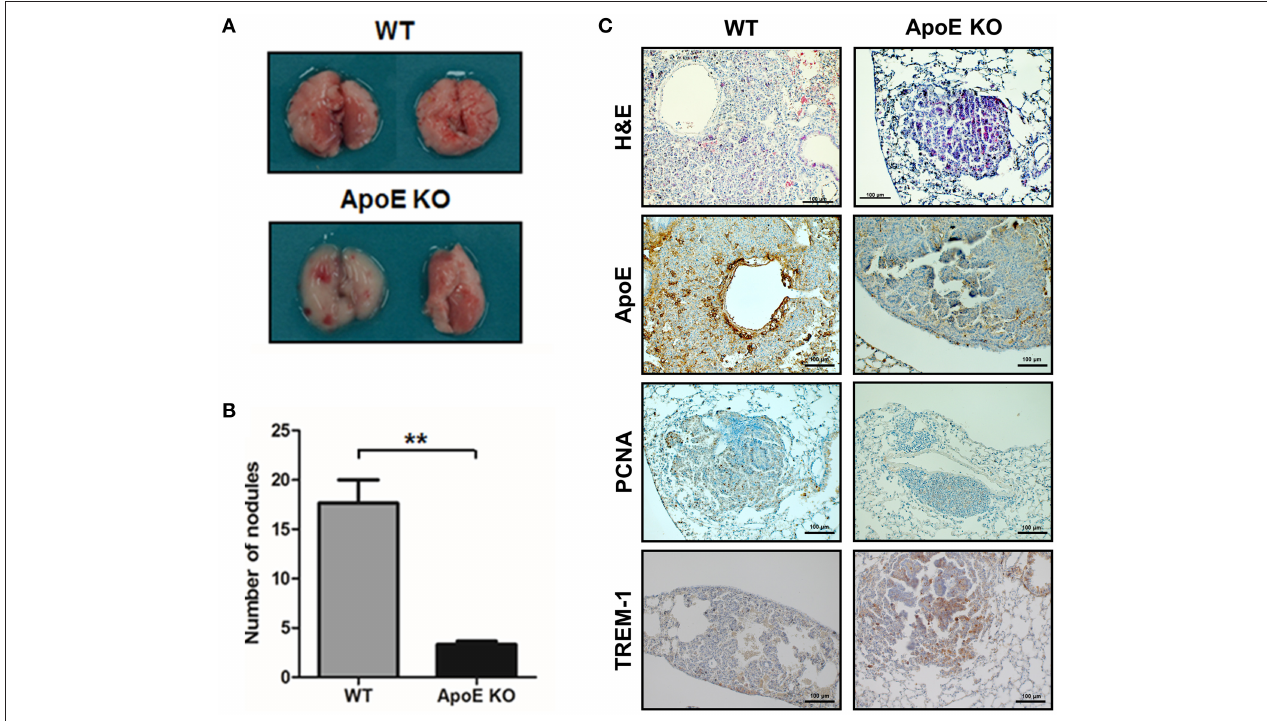
FIGURE 1 | Effect of ApoE knockout on the lung tumor development. (A,B) Tumors were induced by a single intraperitoneal injection of 1 mg/g urethane once a week for 10 weeks ( n = 6). Mice were sacrificed at 6 months after injection of the carcinogen. At the time of sacrifice, numbers of urethane-induced lung tumor were counted. (C) Lung tissues were processed and stained with H&E or analyzed by immunohistochemistry for detection of positive cells for ApoE, PCNA, and TREM-1. Scale bar, 100 µ m. ** p < 0.01.